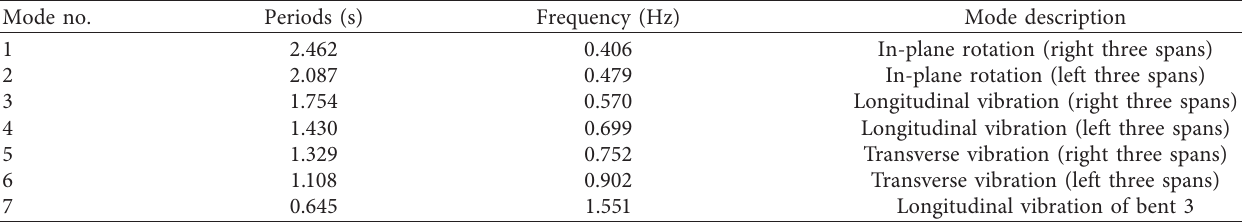
Figure 8: Finite element model. Table 1: First seven natural modes of the bridge.